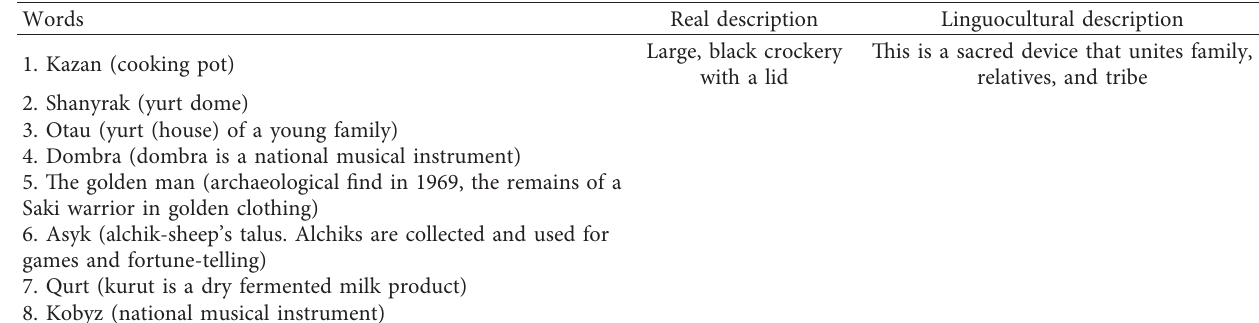
Table 1: Sample table for the